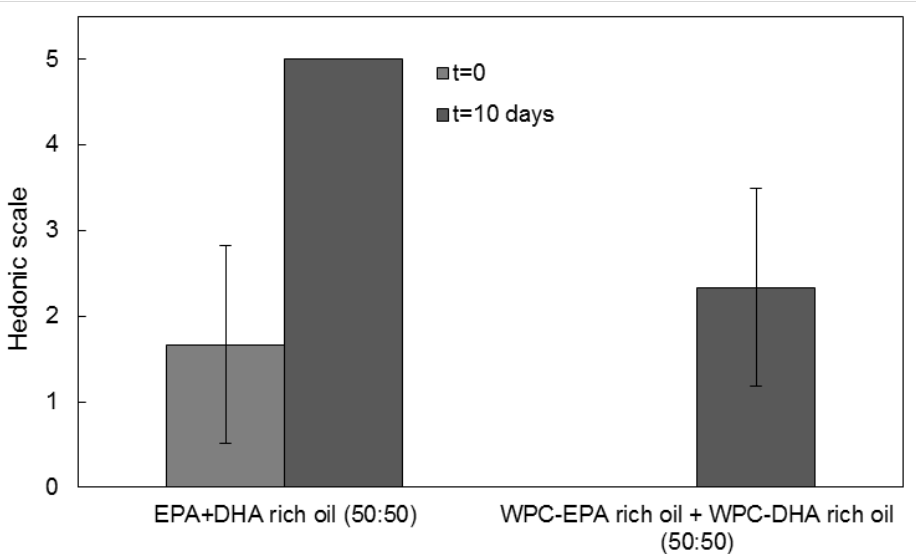
Figure 9. Comparison of the organoleptic impact of reconstituted powder milk containing EPA and DHA enriched free oil (50:50) and EPA and DHA-loaded microcapsules in ratio 50:50, for fresh samples (t = 0) and upon the completion of the accelerated oxidation test. Data were expressed as mean values ± standard deviation.